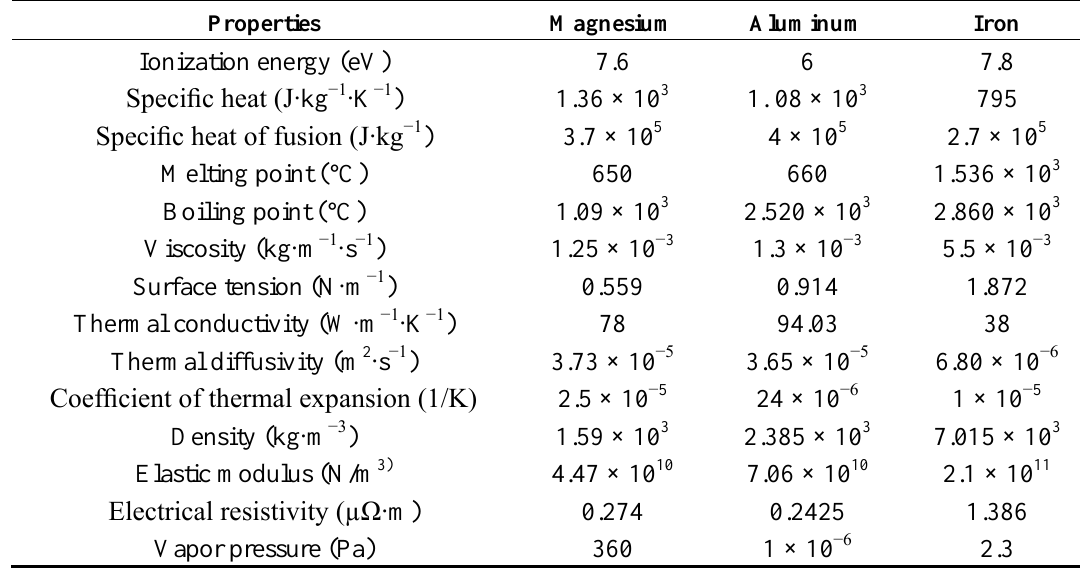
Table 1. Properties of pure magnesium, aluminum and iron at their melting points